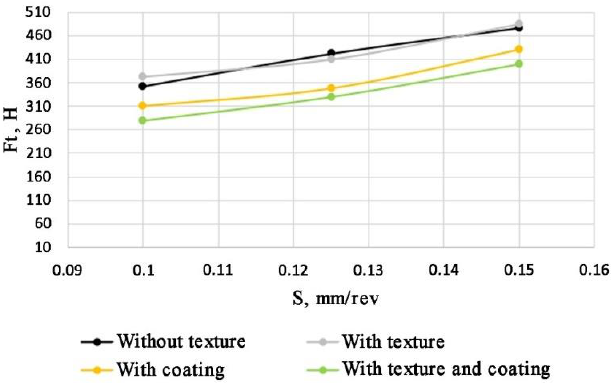
Figure 11. The tangential component of the cutting force on the feed per revolution dependence for various tools at a cutting speed of V = 17 m/min and t = 0.4 mm.